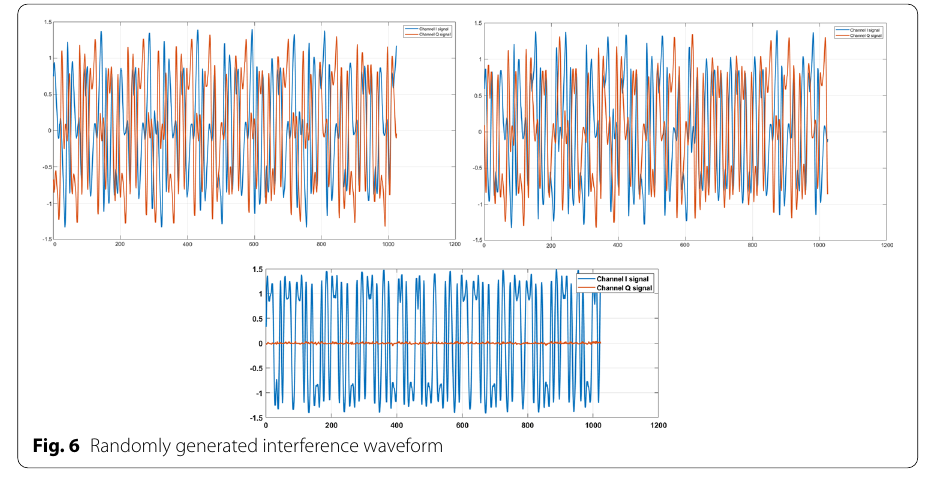
Fig. 6 Randomly generated interference waveform